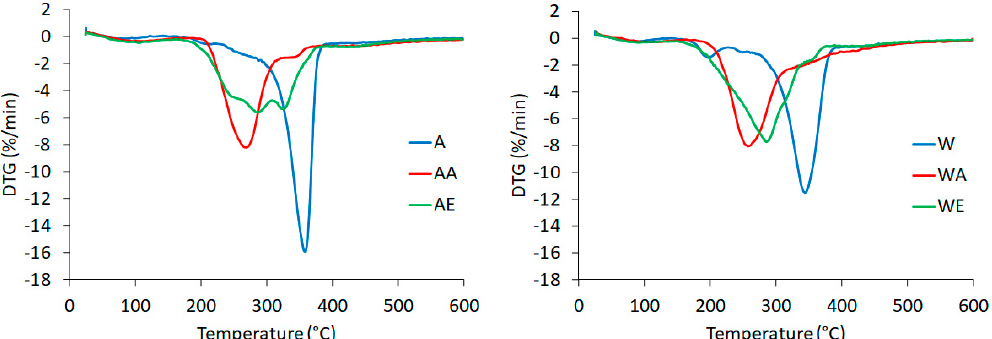
Figure 7. DTG curves of (A) enzyme-pretreated Avicel cellulose, (AA) enzyme-pretreated Avicel cellulose treated with AmimCl, (AE) enzyme-pretreated Avicel cellulose treated with EmimOAc, (W) enzyme-pretreated Whatman cellulose, (WA) enzyme-pretreated Whatman cellulose treated with AmimCl, and (WE) enzyme-pretreated Whatman cellulose treated with EmimOAc.